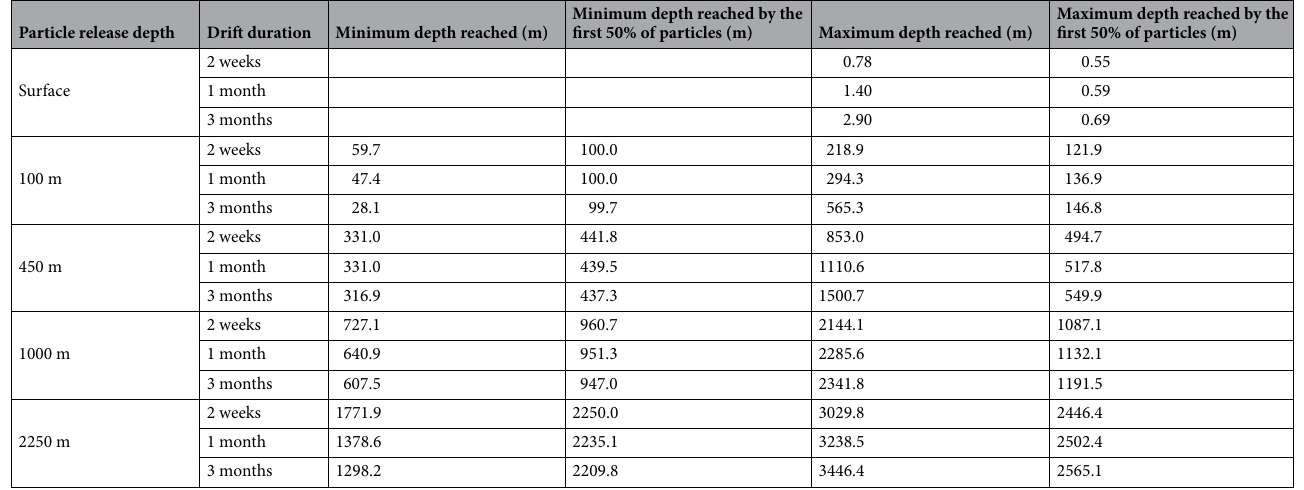
Table 1. Vertical particle displacements. Depths for particles released under different model depth and drift duration scenarios to examine vertical movement. All scenarios used forward-tracked 3-D models and